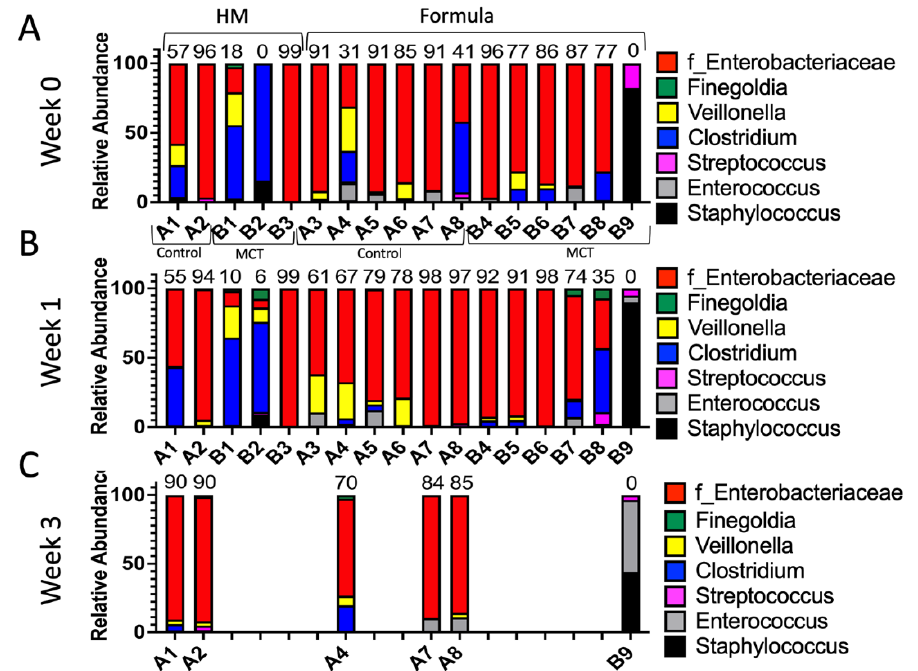
Figure 5. Infant gut microbiota of control vs. MCT-supplemented infants under a human milk or formula diet. Infants were separated into groups based on their type of feed and their stool bacterial communities, as displayed. ( A ) Week 0 indicates samples collected before supplementation began. ( B ) Week 1 indicates samples collected after one week of MCT supplementation. ( C ) Week 3 indicates samples collected after three weeks of MCT supplementation. Infants A1–B3 belong to the human milk group. Infants A3–B9 belong to the formula group. Only six infants remained in the study by week 3. Numbers above bars represent the percentage of Enterobacteriaceae in a particular infant at week 3.